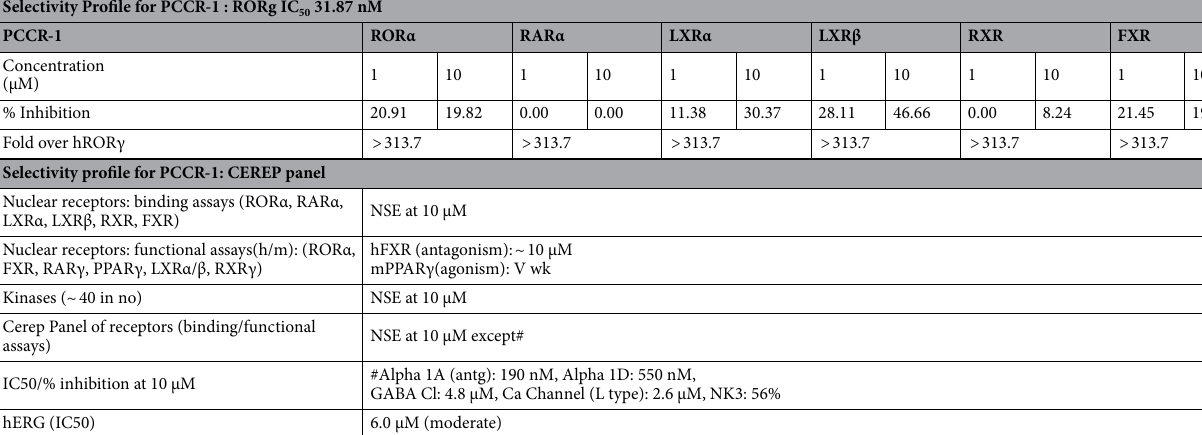
Table 1. In vitro selectivity profile for PCCR-1. NSE No significant effect. V wk very weak (very low-level agonist activity seen with mPPARγ). We represented the Selectivity Profile of PCCR-1: Biochemical activity of PCCR-1 and fold selectivity measured across nuclear receptors w.r.t RORγ and Binding/ functional selectivity profile against panel of receptors and enzymes from Eurofins Cerep,